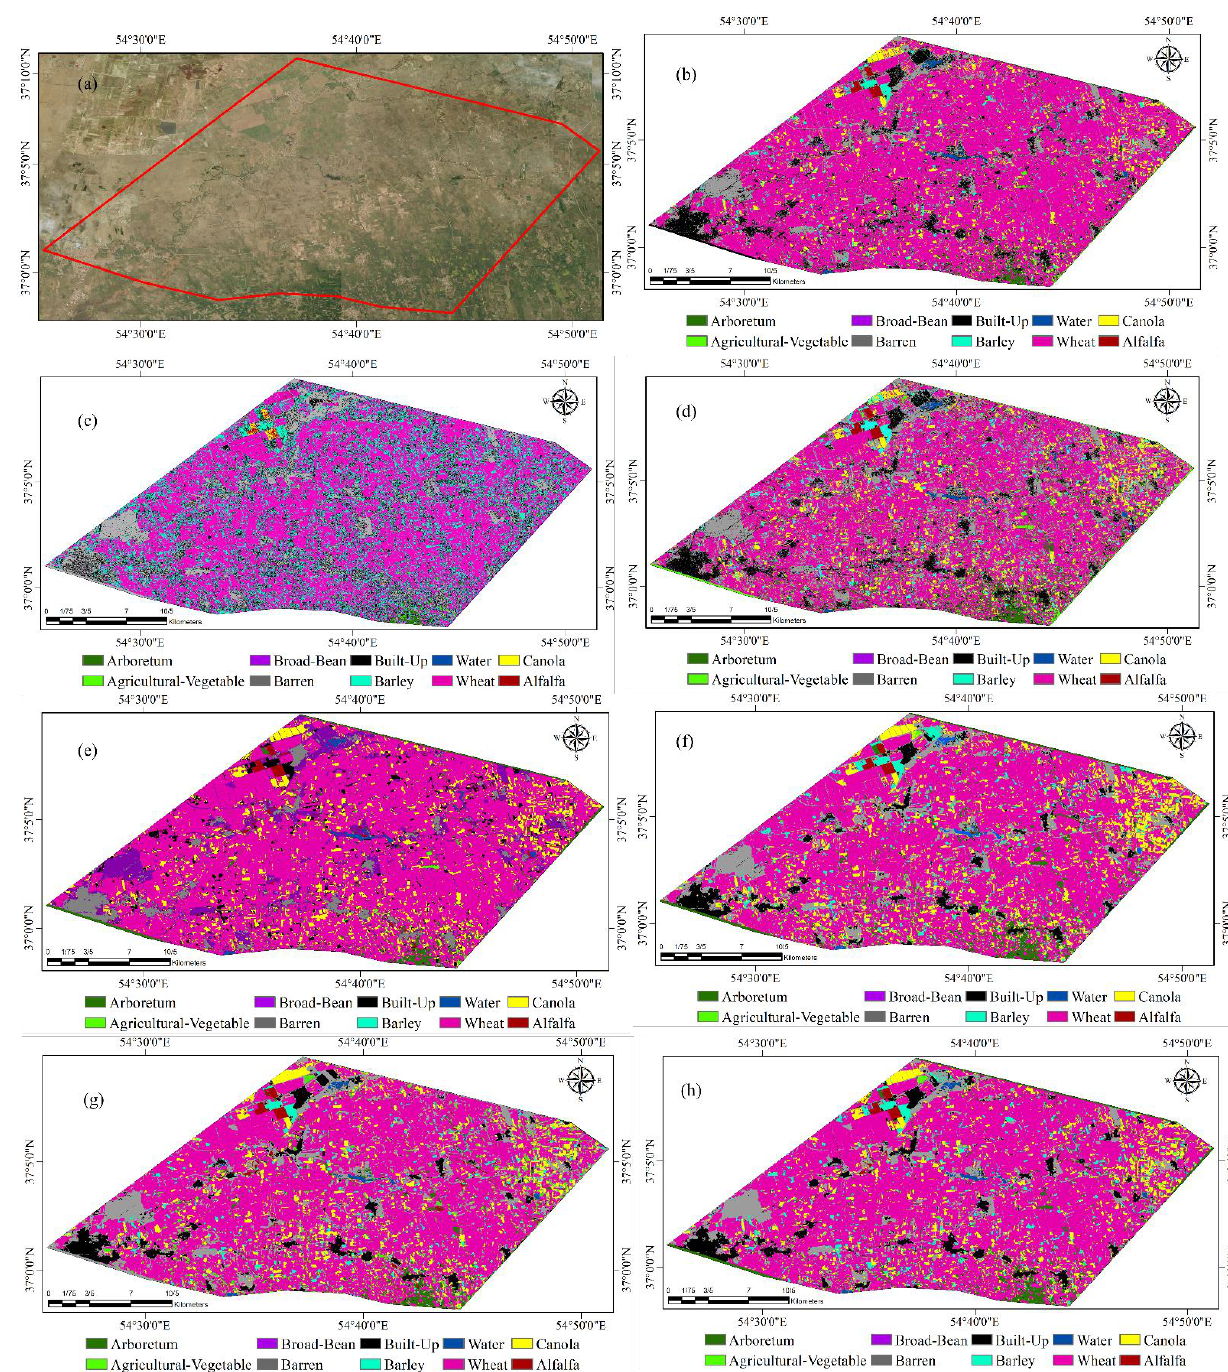
Figure 7. Comparison of the crop maps produced using the proposed algorithm and other classifi- cation methods: ( a ) high resolution satellite image, ( b ) XGBOOST, ( c ) RF, ( d ) R-CNN, ( e ) 2D-CNN, ( f ) 3D-CNN, ( g ) deep learning with an CBAM attention block, and ( h ) proposed method.